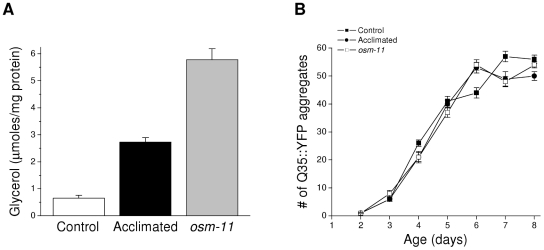
Effect of elevated glycerol levels on aging-induced aggregation of Q35::YFP.
A: Whole worm glycerol levels in controls worms, worms acclimated to 200 mM NaCl and osm-11 mutant animals. (n = 4 samples of ∼4000 worms/sample). B: Time course of aging-induced Q35::YFP aggregation in control, acclimated and osm-11 mutant animals. (n = 7 experiments with 10–15 worms/experiment).